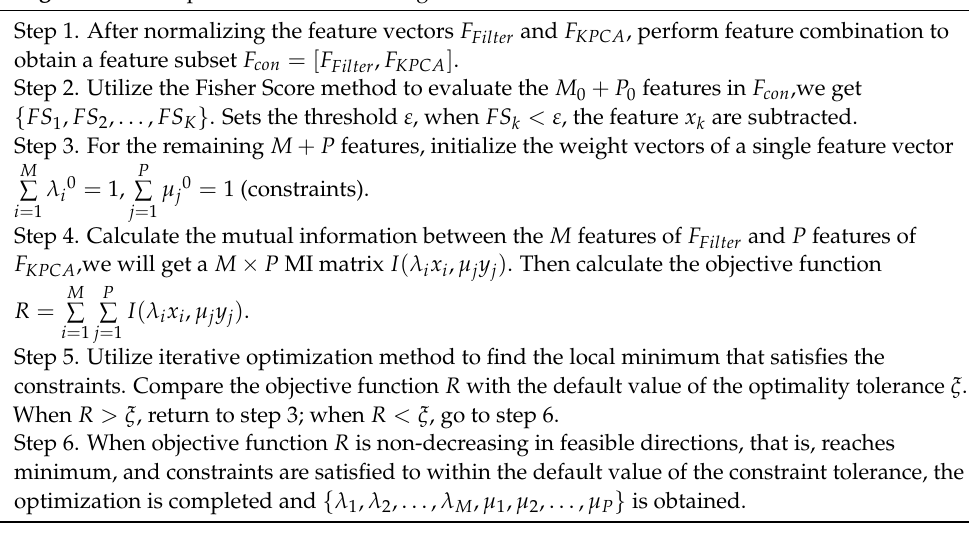
Algorithm 1 The process of the MIMR algorithm